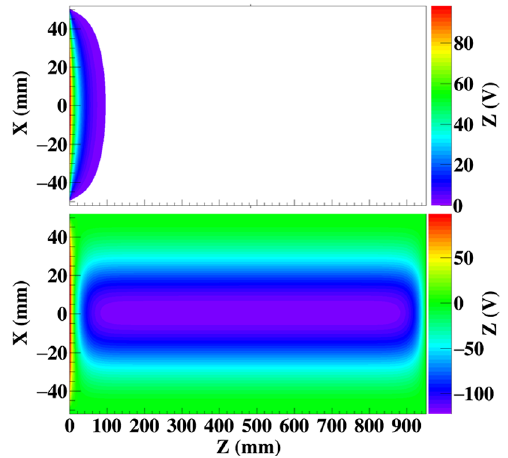
FIG. 1. Laplace solution for beam simulations with boundary conditions (top) and Poisson solution once the beam contribution has been included